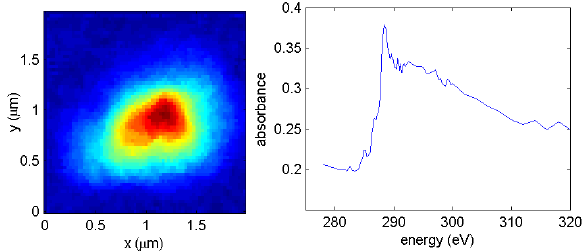
Fig. 7. An example of a particle with strong absorption in the COOH region (288.7eV). The left plot shows the representative absorbance image at 288.85eV, and the right plot shows the average absorbance